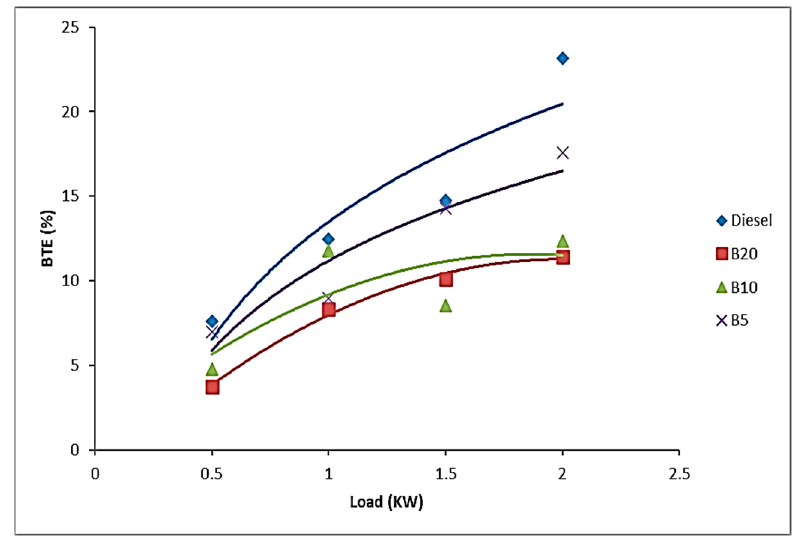
Figure 9. BTE vs. load graph.